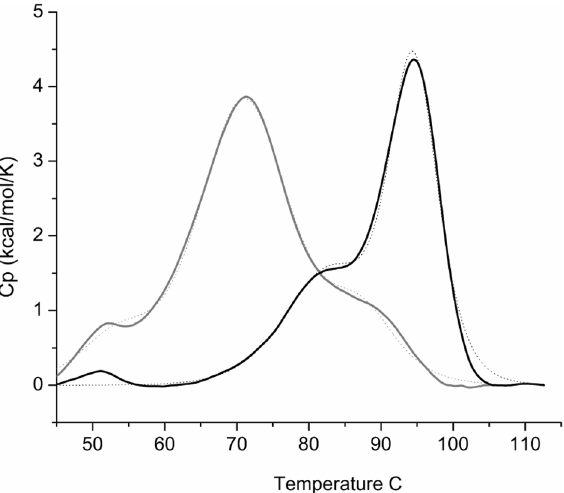
Figure 6. Comparison of the protein stability of variants from Lib-Cheytins 1.0 and Lib-Cheytins 2.1. Heat denaturation of pools of proteins from Lib-Cheytins 1.0 (grey line) and Lib-Cheytins 2.1 (black line) assessed by differential scanning calorimetry (DSC): each pool was purified from a collective production of 11 clones for Lib-Cheytins 2.1 and 12 clones from Lib-Cheytins 1.0 in E.Coli Rosetta (DE3) pLysS. Each pool of proteins was loaded at 1.7 mg mL −1 . All the clones of each pool have been controlled by SDS-PAGE for their soluble expression in E. coli (see supplementary data Fig.